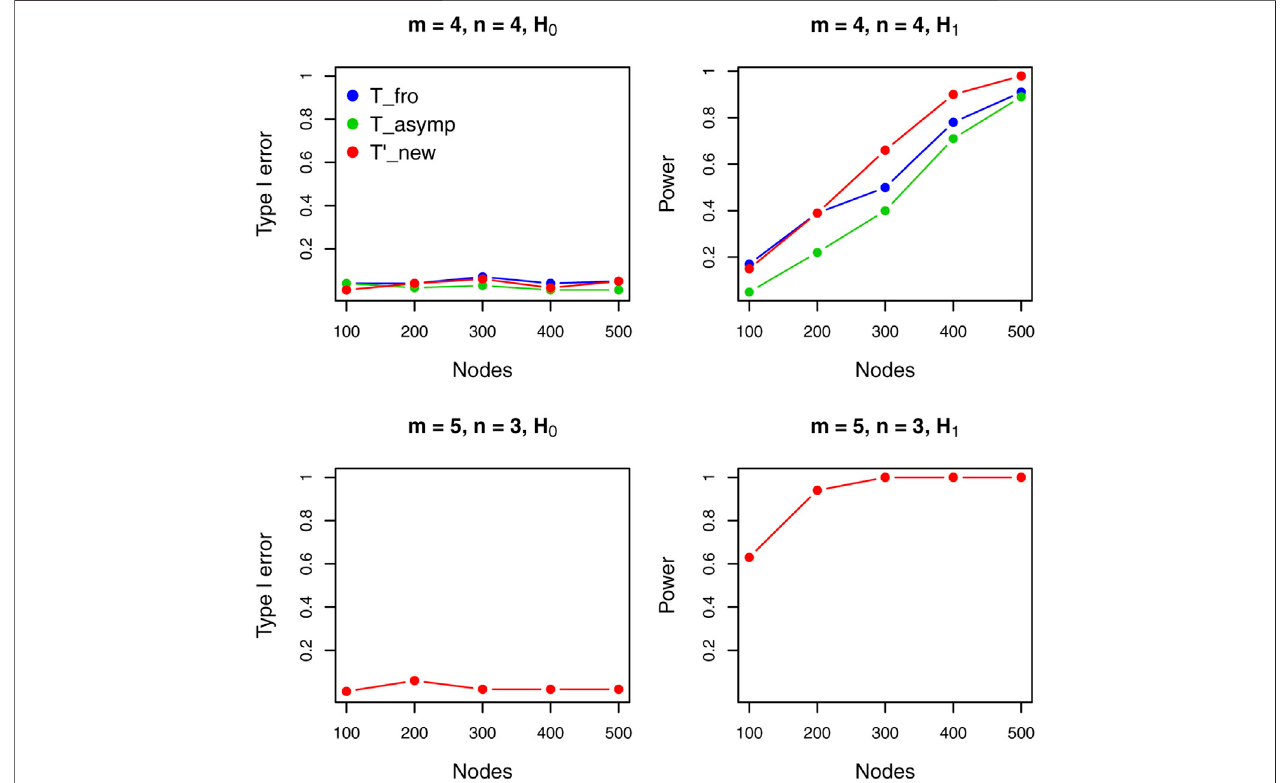
FIGURE 1 | Performance comparison of different tests for undirected